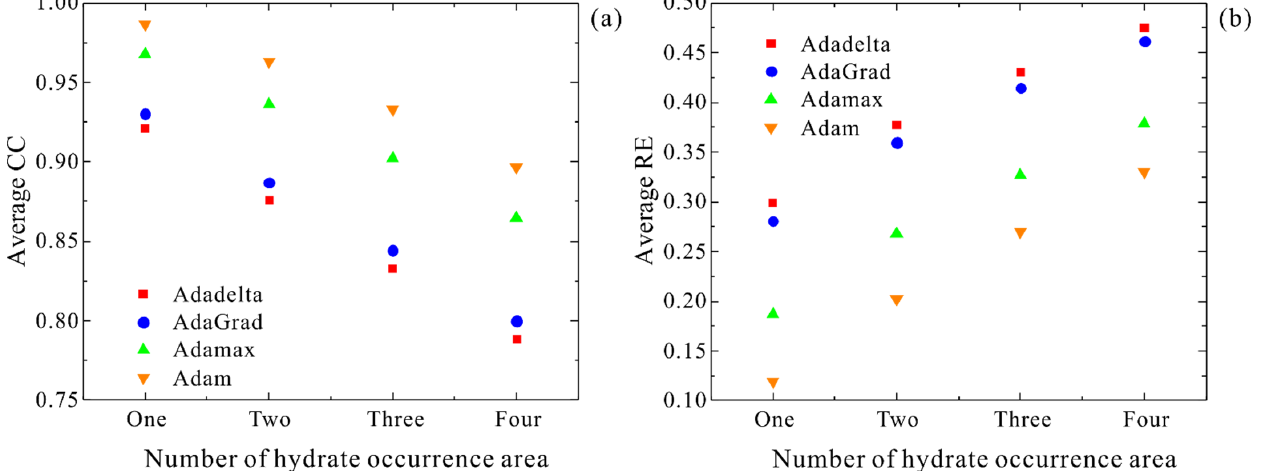
Figure 13. The average RE and CC of different samples in the test set for different optimizers. ( a ) average CC, ( b ) average RE.